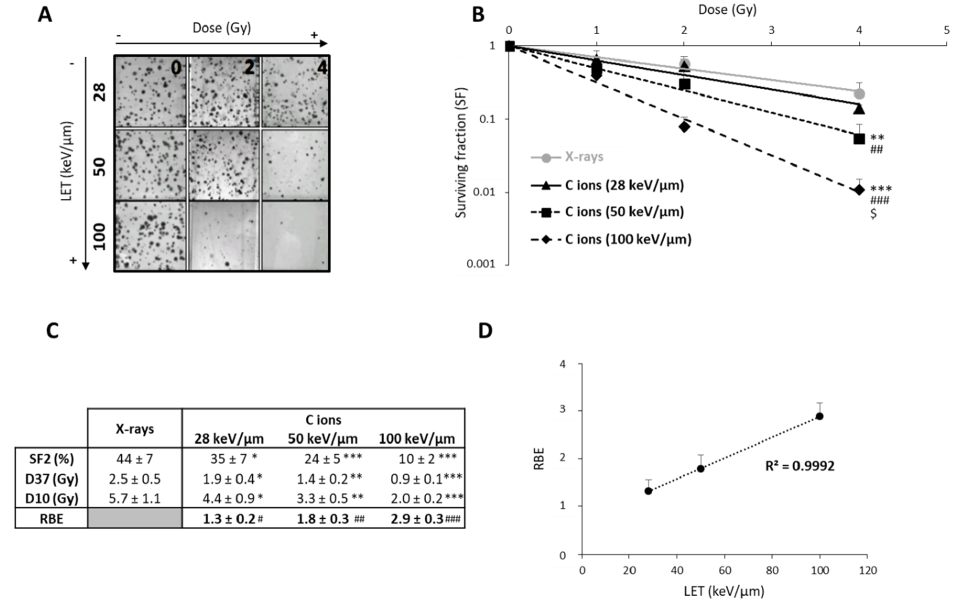
Figure 1. Radiosensitivity of U251 glioblastoma cells as a function of linear energy transfer (LET). ( A ) Representative photographs of U251 colonies obtained 10 days after carbon ion irradiation at 0, 2, and 4 Gy with different LET (28, 50, and 100 keV/µm); ( B ) Survival curves of U251 cells exposed under normoxia (21% O 2 ) to X-rays or carbon ions with physical doses ranging from 0 to 4 Gy. Fisher’s LSD post-hoc test after a significant two-way ANOVA (group and dose effects): ** p < 0.01, *** p < 0.0001 vs. X-rays; ## p < 0.01, ### p < 0.0001 vs. C ions 28 keV/µm; and $ p < 0.0001 vs. C ions 50 keV/µm; ( C ) Comparison of radiological parameters obtained from the fit of survival curves for the different irradiation types. For SF2 (survival fraction at 2 Gy), D37, and D10 (doses leading to 37% and 10% of survival, respectively): * p < 0.05, ** p < 0.01, *** p < 0.0001 vs. X-rays (Fisher’s LSD post-hoc test after a significant one-way ANOVA). For RBE (relative biological e ff ectiveness = ratio of D37 X-rays / D37 carbon ions): # p < 0.05, ## p < 0.01, ### p < 0.0001 vs. theoretical value = 1